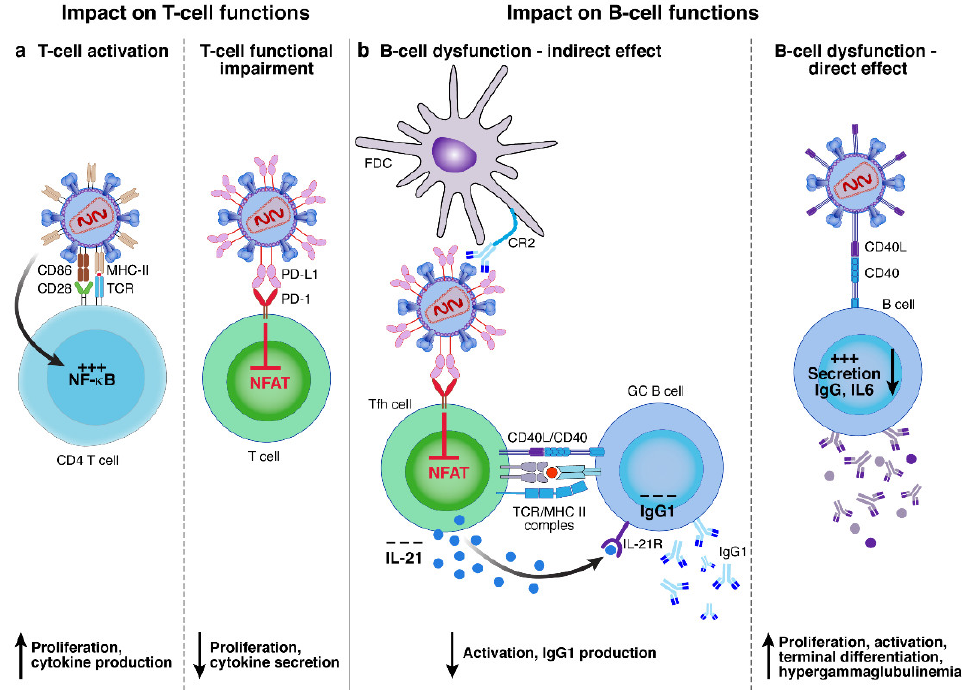
Figure 5. Potential influence of host protein incorporation on T and B cell responses. The incorpora- tion of host molecules might influence HIV pathogenesis by modulating T and B cell responses: ( a ) the co-incorporation of HLA-DR and CD86 into HIV virions may favor T-cell activation by increasing NF- κ B pathway. The incorporation of PD-L1 into HIV virions may favor T-cell functional impairment by inhibiting NFAT pathway; and ( b ) the incorporation of PD-L1 impacts B-cell functions through an indirect mechanism, by impairment of Tfh cell functions, which in turn may fail to provide efficient B-cell support. The impact of incorporated molecules on B-cell functions might involve direct or indirect interactions. The incorporation of CD40L into HIV virions interacts with CD40 + B cells and may promote B-cell